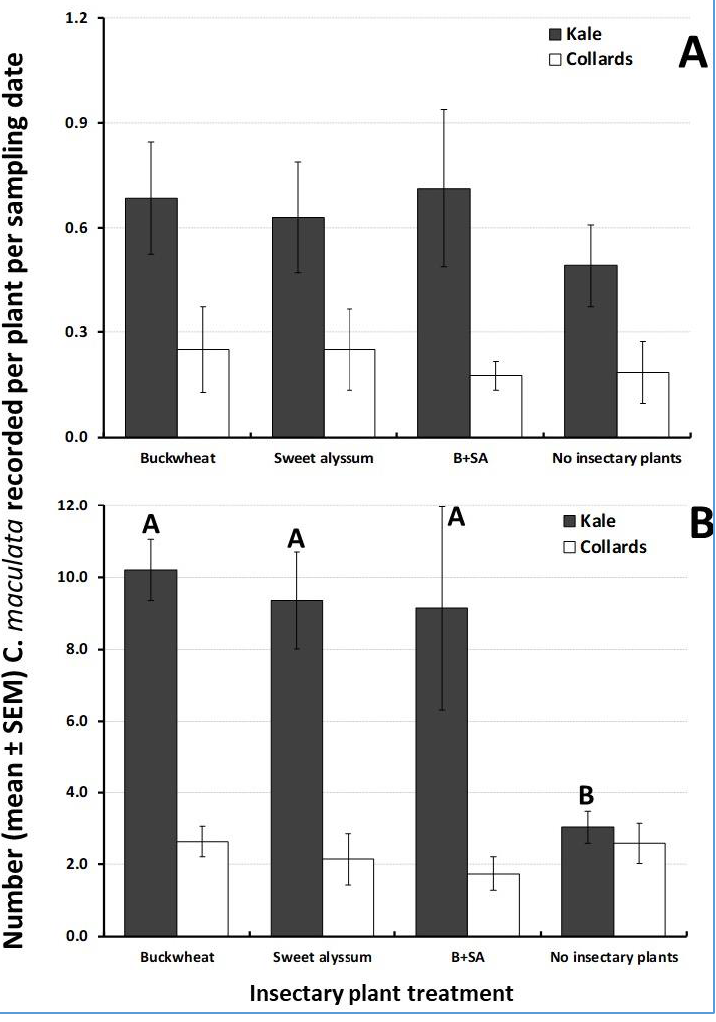
Figure 4. Trap crop pink lady beetle, Coleomegilla maculata , abundance on a per-plant basis. ( A ) adult stage, ( B ) immature stage (eggs and larvae combined). For each trap crop species, bars with di ff erent letters are significantly di ff erent according to ANOVAS and Fisher-protected LSD tests ( p < 0.05).